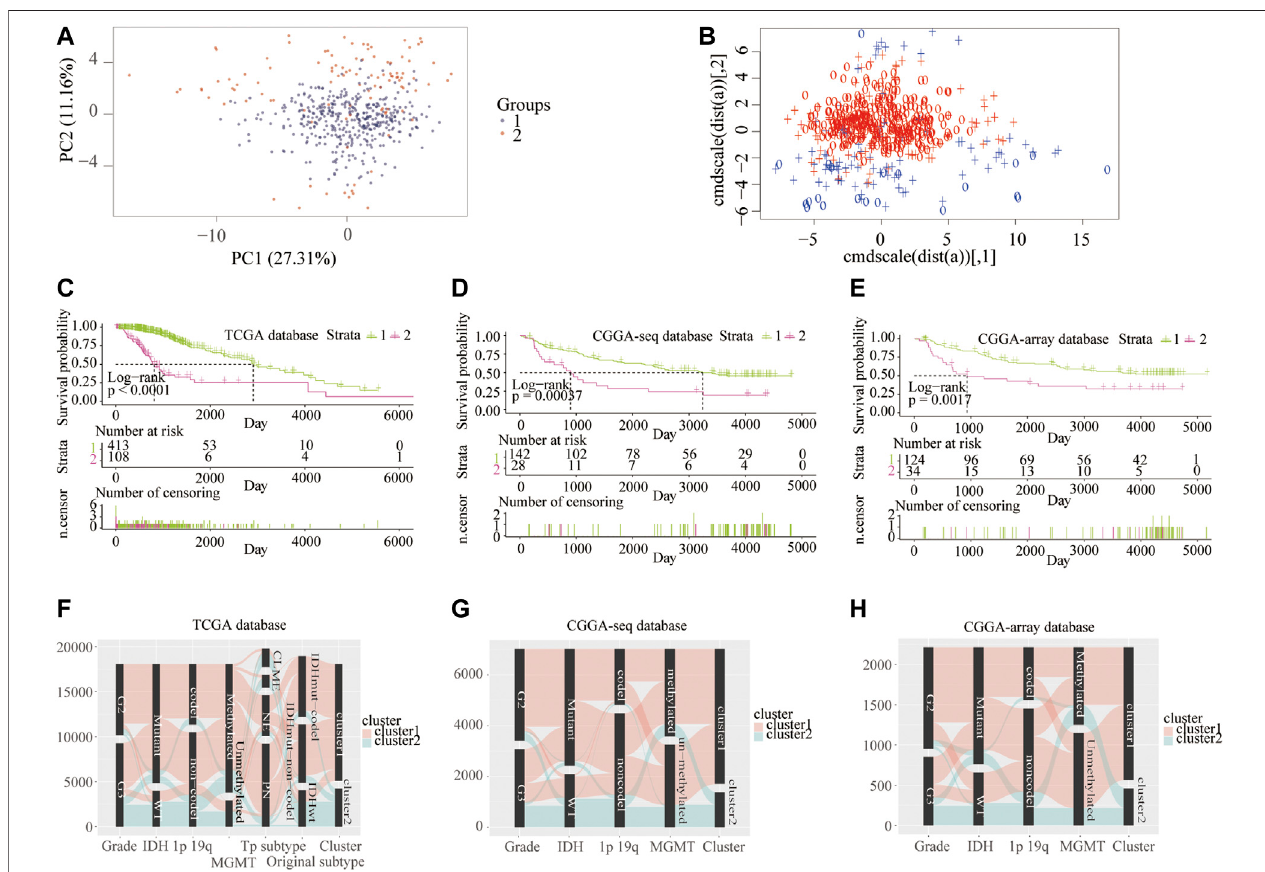
FIGURE 2 | Consensus clustering of samples into cluster 1 and cluster 2 from the training and validation cohorts. Consensus clustering patients into two clusters using principal component (A) and support vector machine analysis (B) from the TCGA database. Kaplan – Meier overall survival curve between two clusters from the TCGA (C) , CGGA-sequence (D) , and CGGA-array (E) databases. Sankey diagram shows LGG clinicopathologic features between two clusters from the TCGA (F) , CGGA-sequence (G) , and CGGA-array (H) databases.